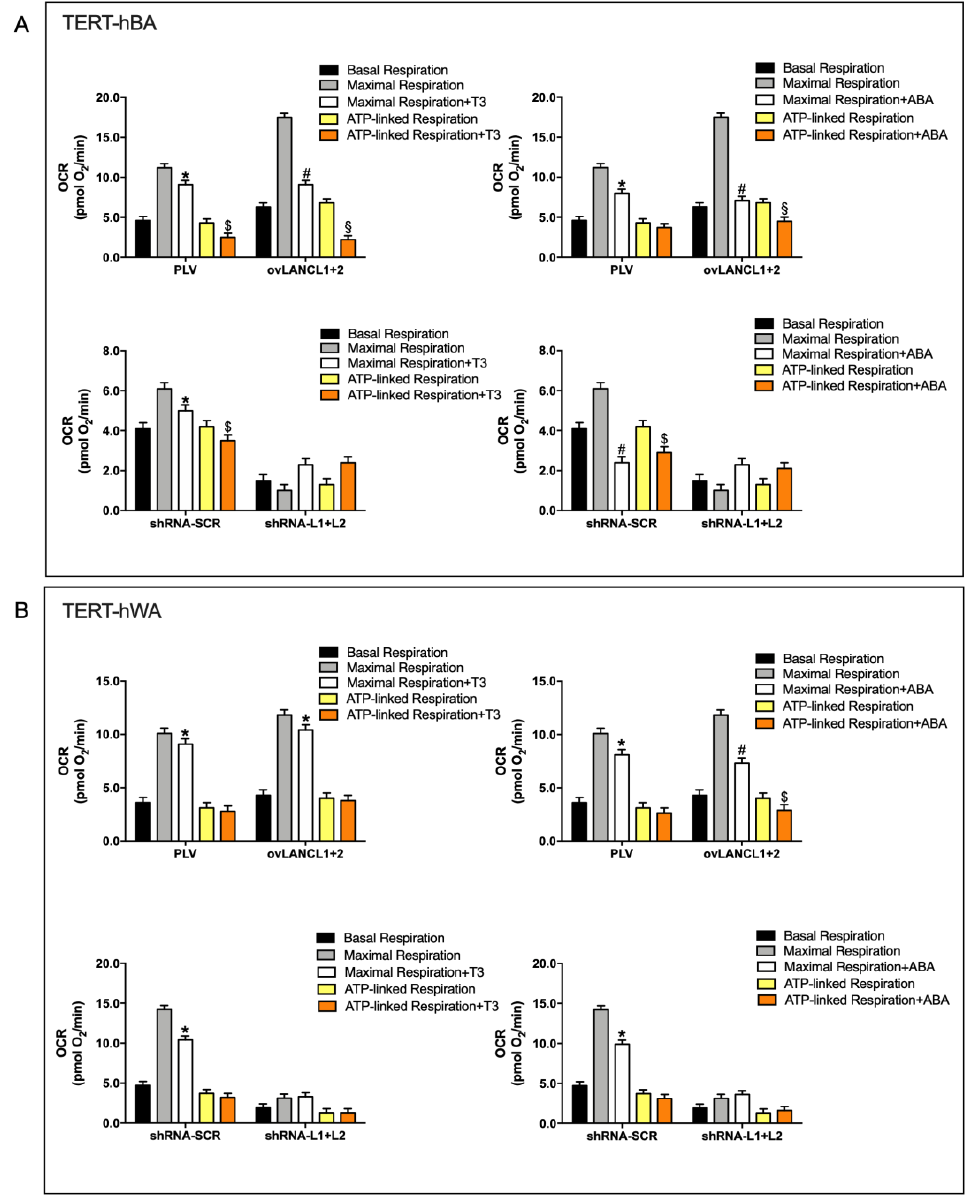
Figure 6. Mitochondrial respiration and uncoupling are controlled by LANCL1/2 expression levels in differentiated white and brown adipocytes. White (TERT-hWA) and brown (TERT-hBA) adipocytes, either overexpressing LANCL1/2 (ovLANCL1+2) and their controls, infected with the empty vector (PLV), or silenced for LANCL1/2 (shRNA-L1+L2) and their controls, infected with the scrambled silencing sequences (shRNA-SCR) were differentiated (up to day 12 of culture for brown adipocytes and up to day 15 of culture for white-derived “beige” adipocytes). Respiration measurements were performed using the Seahorse XFp Analyzer, with the sequential addition of oligomycin, FCCP and rotenone/antimycin A. Maximal and ATP-linked oxygen consumption rates (OCR) were measured in the absence or presence of 100 nM T3 or 100 nM ABA. ( A ) OCR of TERT-hBA; upper panels, LANCL1/2-overexpressing adipocytes, treated with T3 (left) or with ABA (right); lower panels, LANCL1/2-silenced adipocytes, treated with T3 (left) or with ABA (right). ( B ) OCR of TERT-hWA; upper panels, LANCL1/2-overexpressing adipocytes, treated with T3 (left) or with ABA (right); lower panels, LANCL1/2-silenced adipocytes, treated with T3 (left) or with ABA (right). * p < 0.05 and # p < 0.01 relative to maximal respiration without treatment (gray bar); $ p < 0.05 and § p < 0.01 relative to ATP-linked respiration without treatment (yellow bar), by unpaired t - test. Data shown are the mean ± SD of 3 experiments per group, with each value calculated in trip- licate.